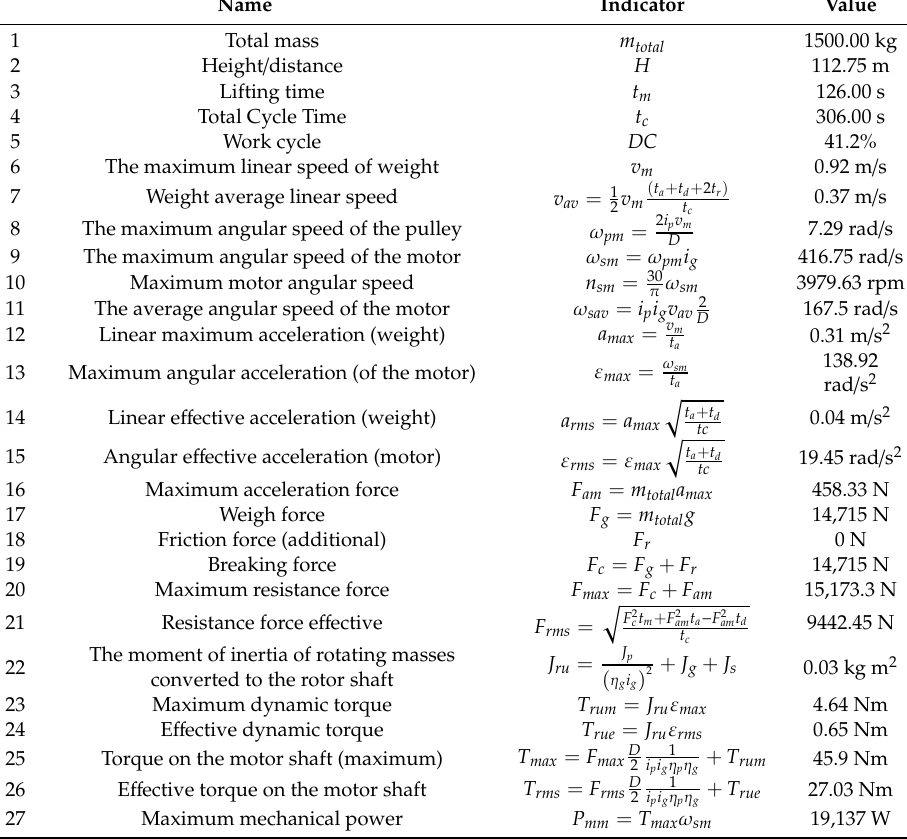
Table 4. Checking calculation results for the correctness of hoist motor